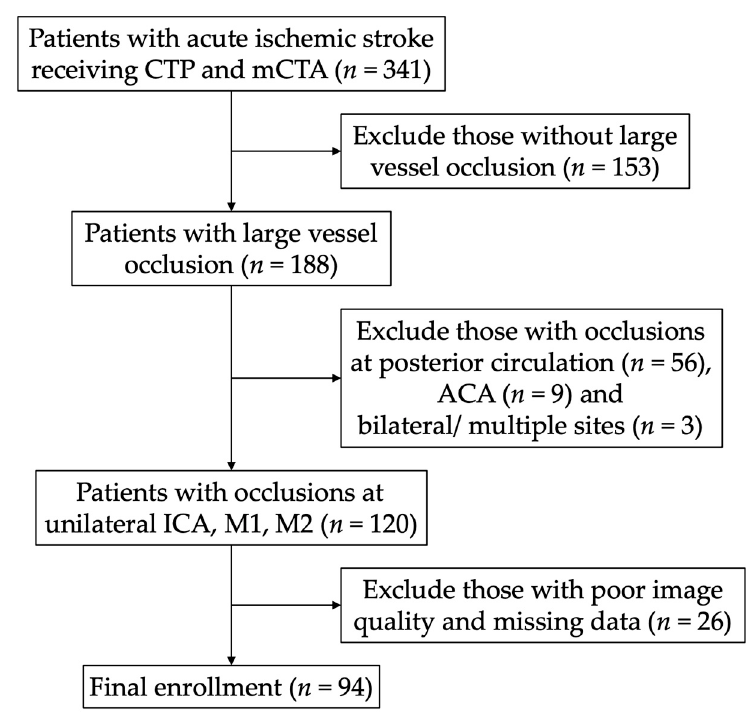
Figure 1. The flow chart of enrollment. CTP, computed topography perfusion; mCTA, multiphase computed topographic angiography; ACA anterior cerebral artery; ICA, internal carotid artery; M1/M2, M1, and M2 segments of the middle cerebral artery.